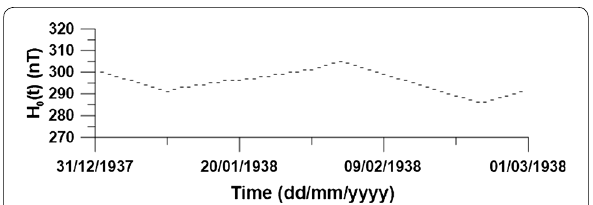
Fig. 14 Graph of base line values at Ebro (January–February 1938)